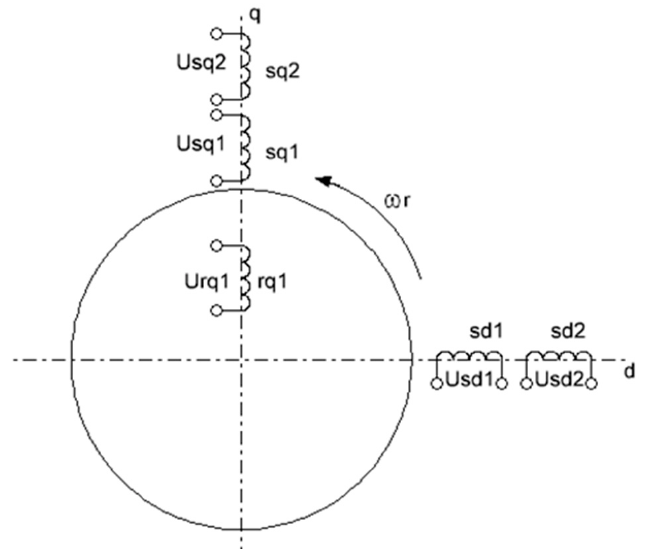
Figure 7. Electric circuit of a double-phase generator.